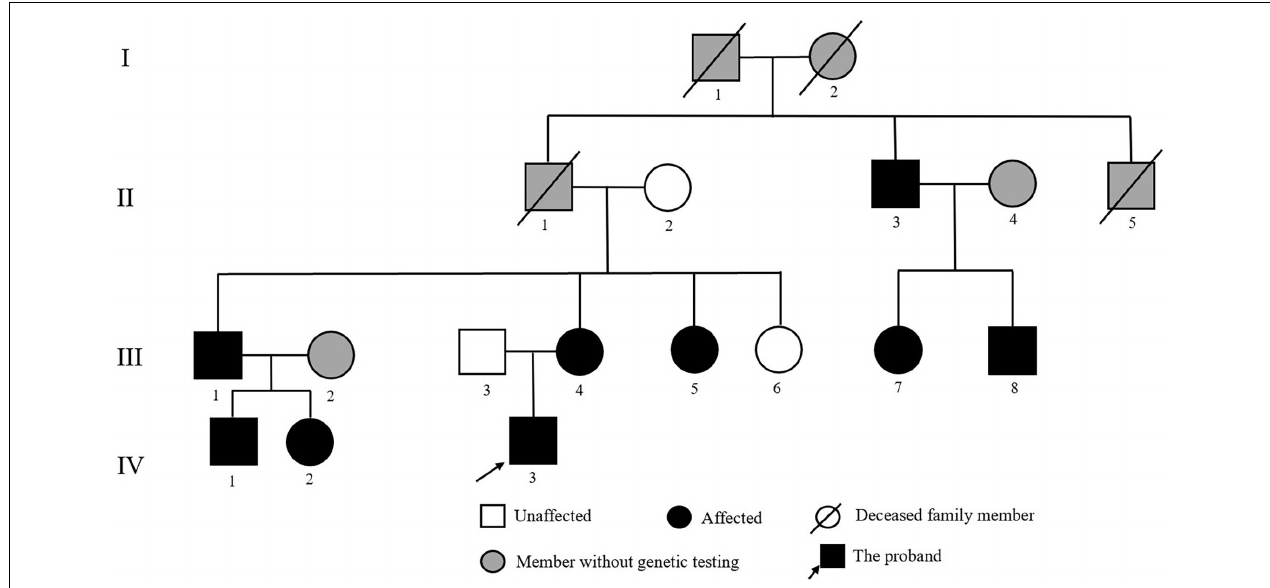
FIGURE 1 | Pedigree of the Chinese family with Liddle syndrome. The arrow indicates the proband; black symbols represent Liddle syndrome patients identified by genetic testing; and gray symbols indicate member without genetic testing.